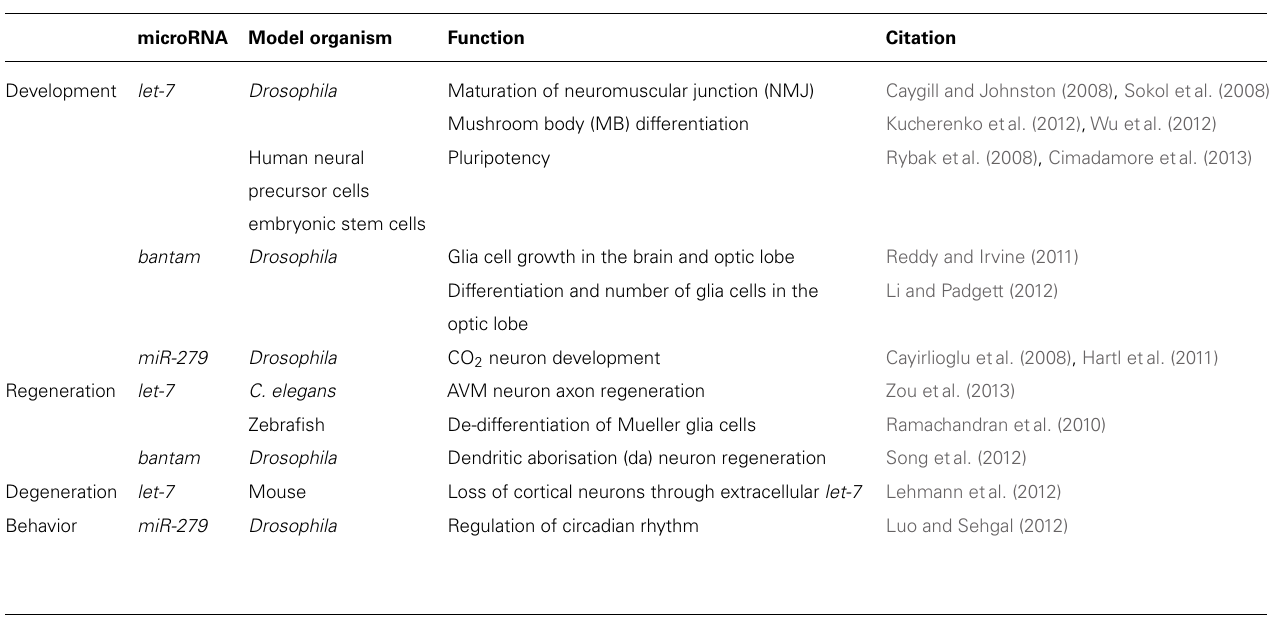
Table 1 | Conserved functions of let-7 , bantam, and miR-279 in the nervous